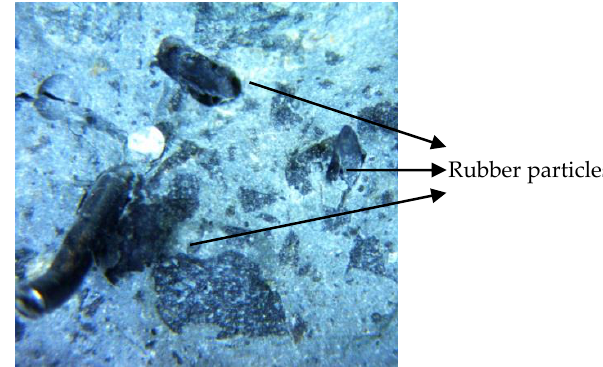
Figure 9. Rubber particles reserved in fiber holes on a fracture surface of a notched specimen after fracture energy